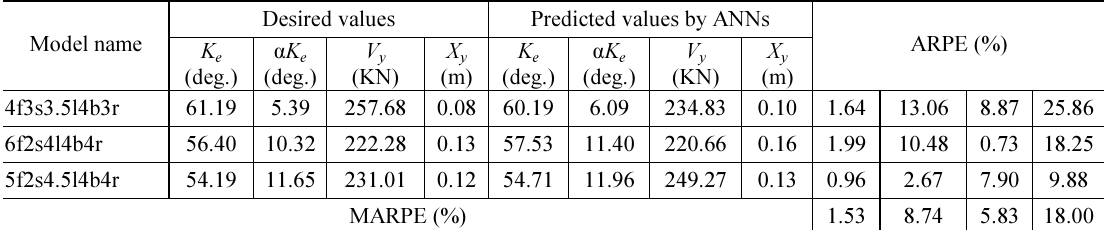
Table 8. Final results of ANNs application for testing datasets Desired values Predicted values by